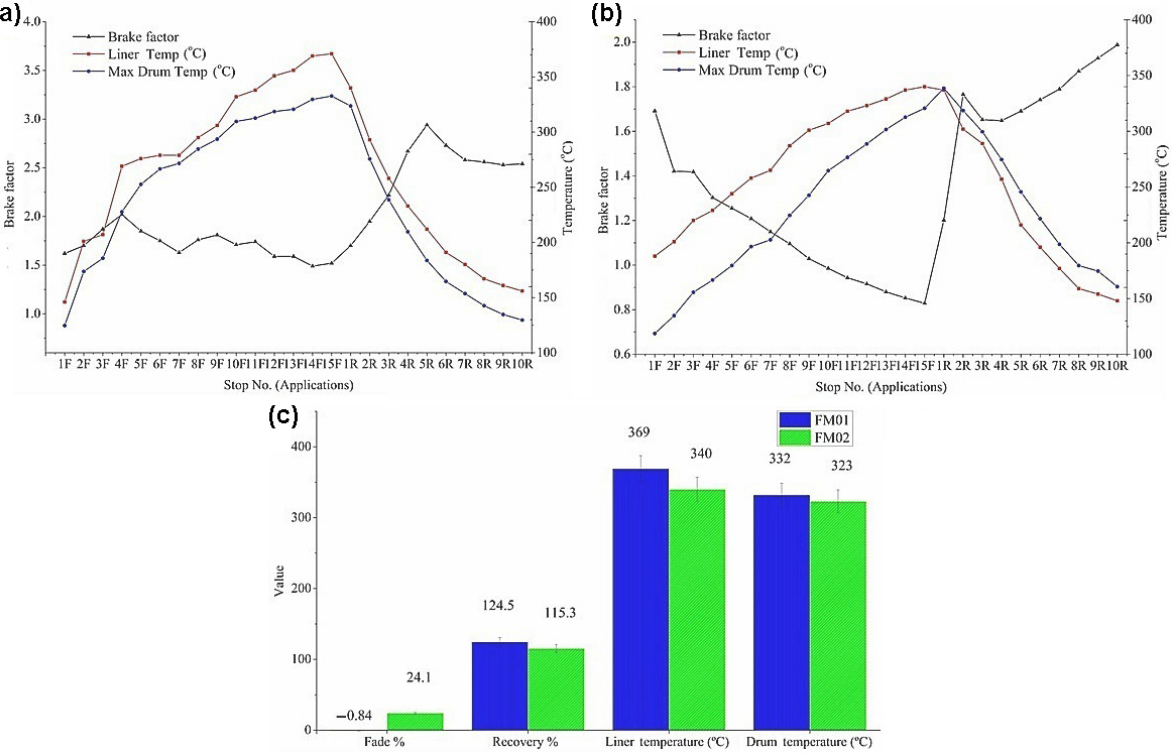
Fig. 6 (a) Fade, recovery, liner, and drum temperatures of the FM01 composite, (b) fade, recovery, liner and drum temperatures of the FM02 composite, and (c) fade and recovery percentage with the maximum rise in drum and liner temperatures of tested friction